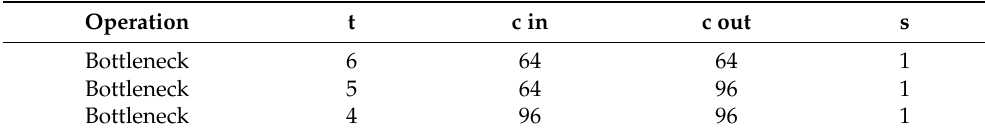
Table 2. Details of Bottleneck block.